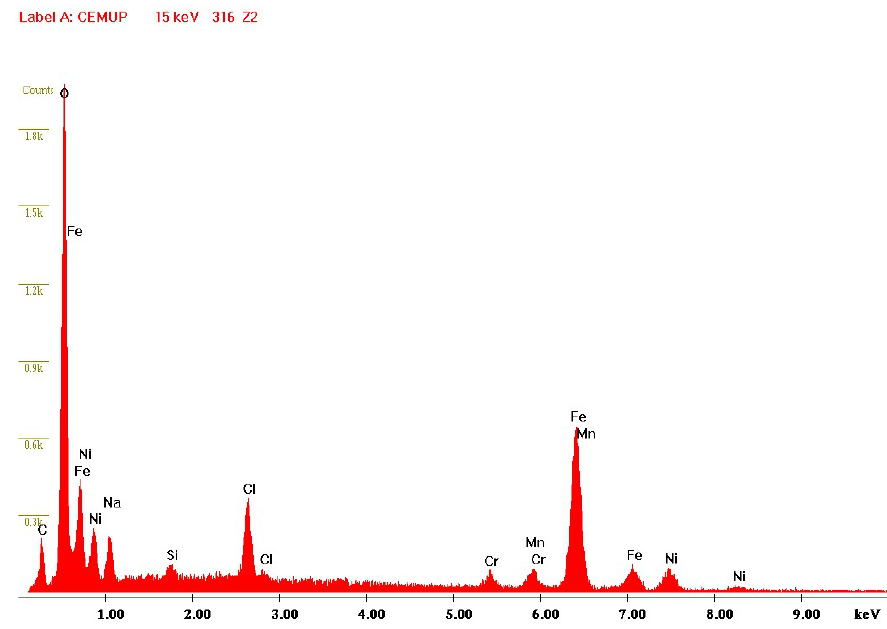
Figure A2. EDS of the red zone in the first AISI 316L SEM image.